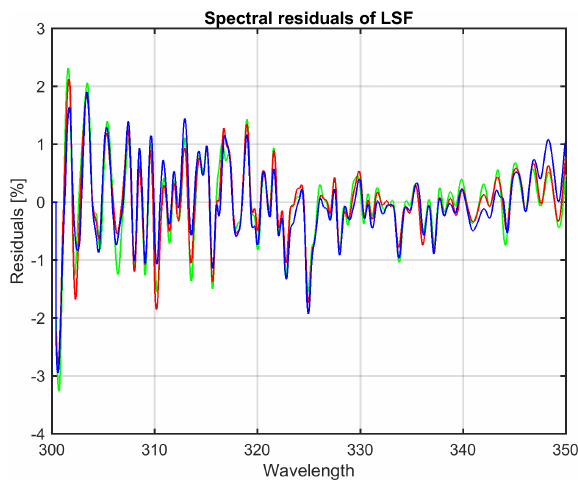
Figure 1. Spectral residuals of the measured and the modeled spec- tra of the best fit from the LSF algorithm. The exemplary figure shows three spectra at local noon and retrieved TCO of 303DU. The average of the residuals of the irradiance over all wavelengths is less than